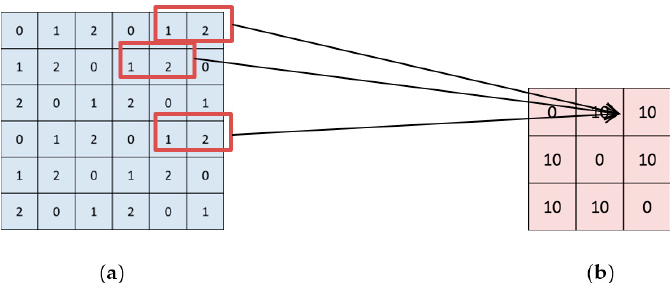
Figure 5. A possible example of luminance map and associated Gray-level co-occurrence matrix (GLCM) map of an image. ( a ) is the luminance map I ; ( b ) is the GLCM map.